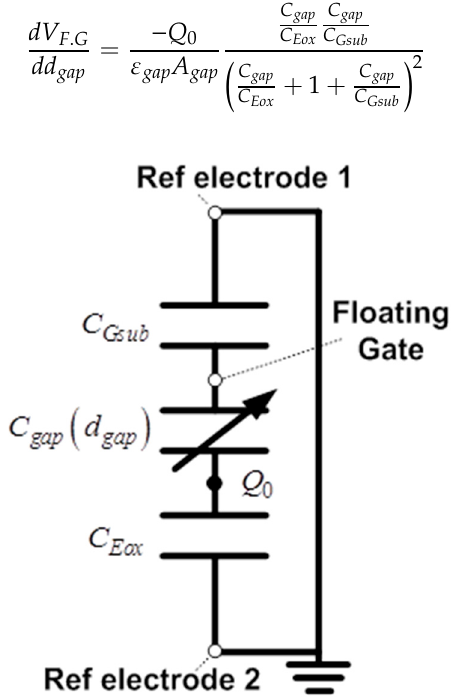
Figure 2. Equivalent circuit model of the ElGoFET structure. C Gsub , C gap , and C Eox represent the equivalent capacitance between the floating gate electrode and reference electrode, electret and floating gate electrode, and electret and reference electrode, respectively. The electret is expressed as a fixed charge ( Q 0 ) in the model.